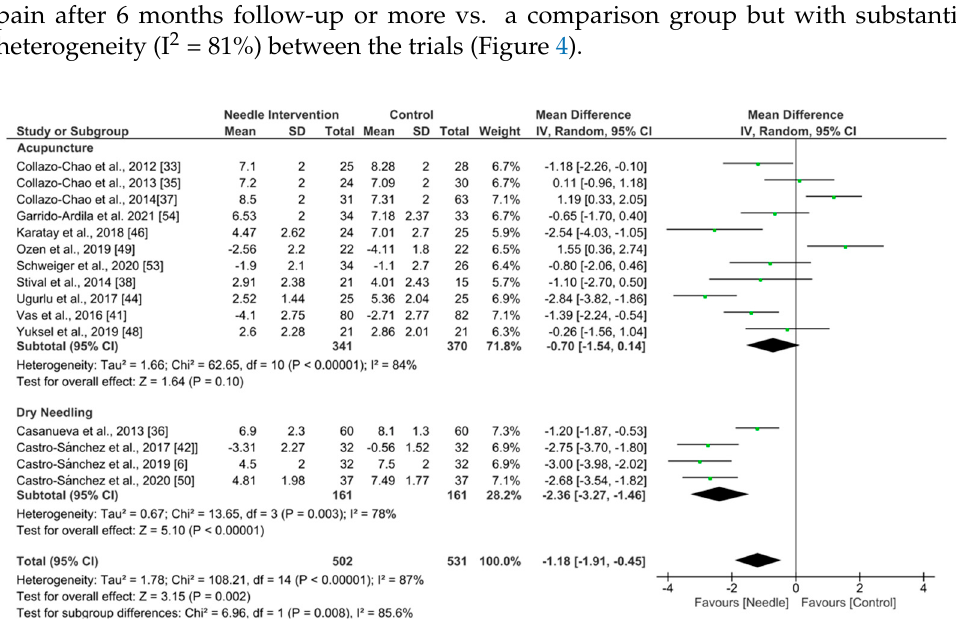
Figure 2. Forest plot for Pain Intensity after 0–3 months.